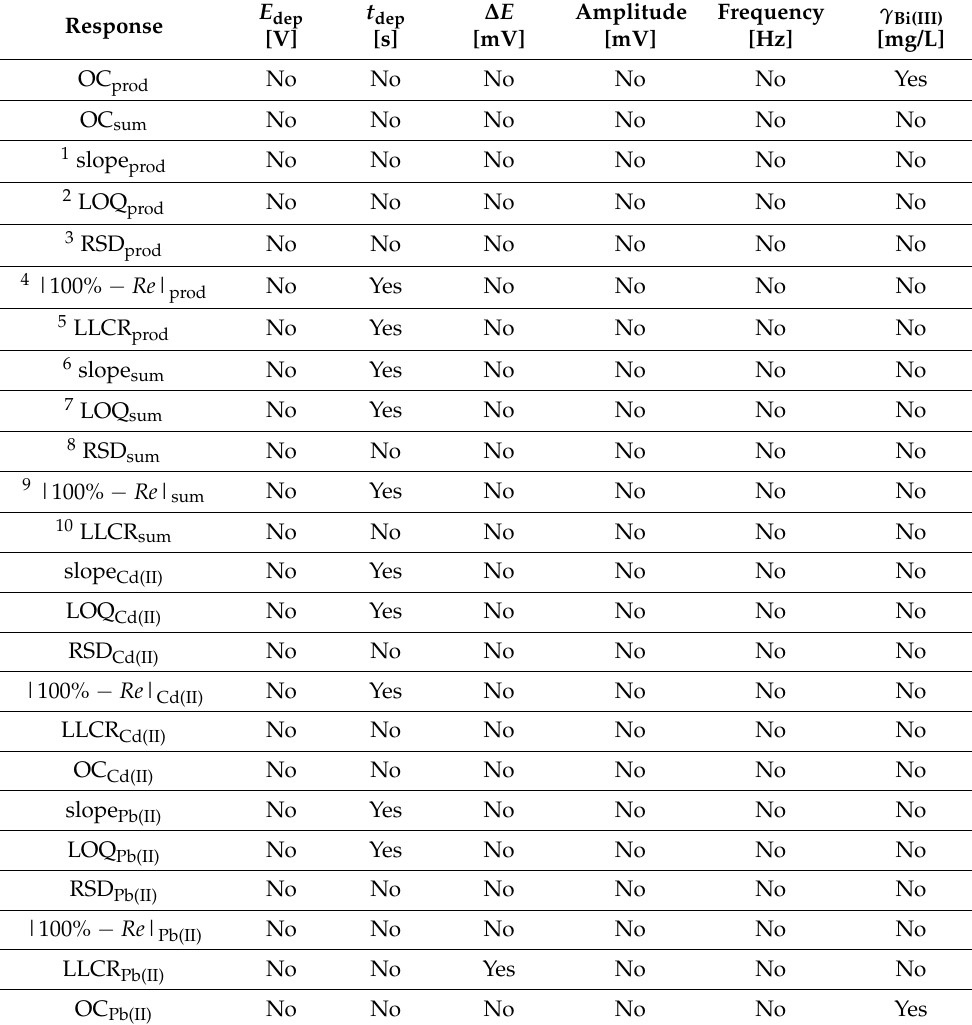
Table 3. The FI on individual validation parameters (“No” or “Yes” is the answer if the factor has a significant impact on the given